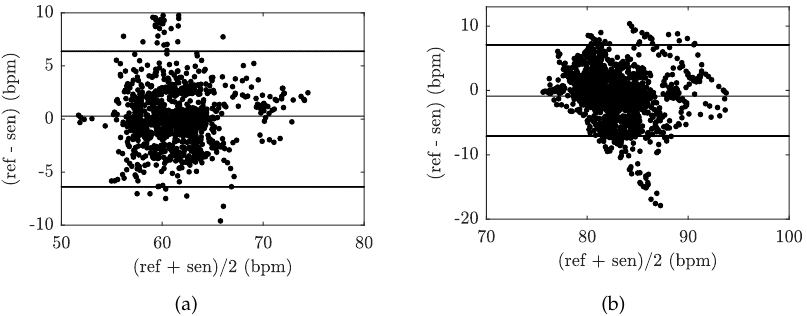
Figure 15. Reproducibility of HR determination capabilities of our FBG sensor (based on comparison with ECG-based HR calculations) using the Bland–Altman analysis method and data acquired from: ( a ) volunteer M1, and ( b ) volunteer